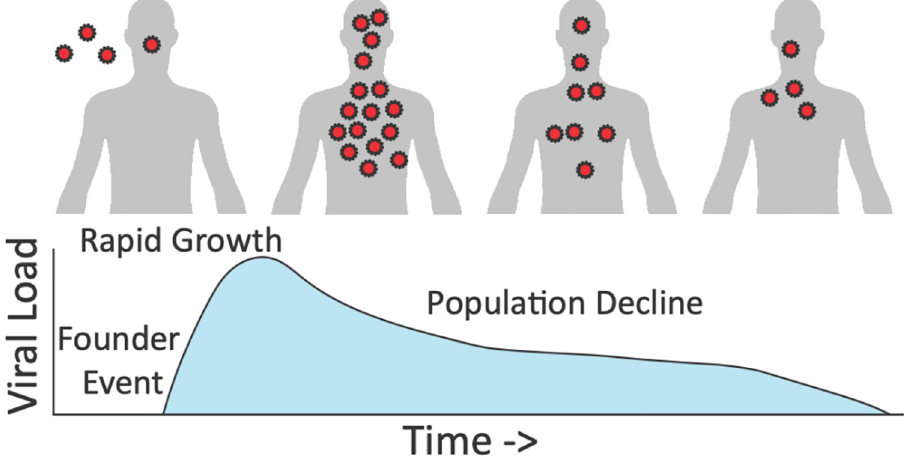
Fig 3. A schematic of a simple intra-host demographic model potentially underlying infection dynamics. At the time of infection, the virus population will initially be characterized by a population bottleneck associated with the founder event. A successful infection will next be characterized by rapid population growth associated with high viral loads, and reducing sizes and loads as the patient begins to clear the infection. The details of this infection history will greatly shape the observed levels and patterns of intra-host diversity. Viral load schematic modified from